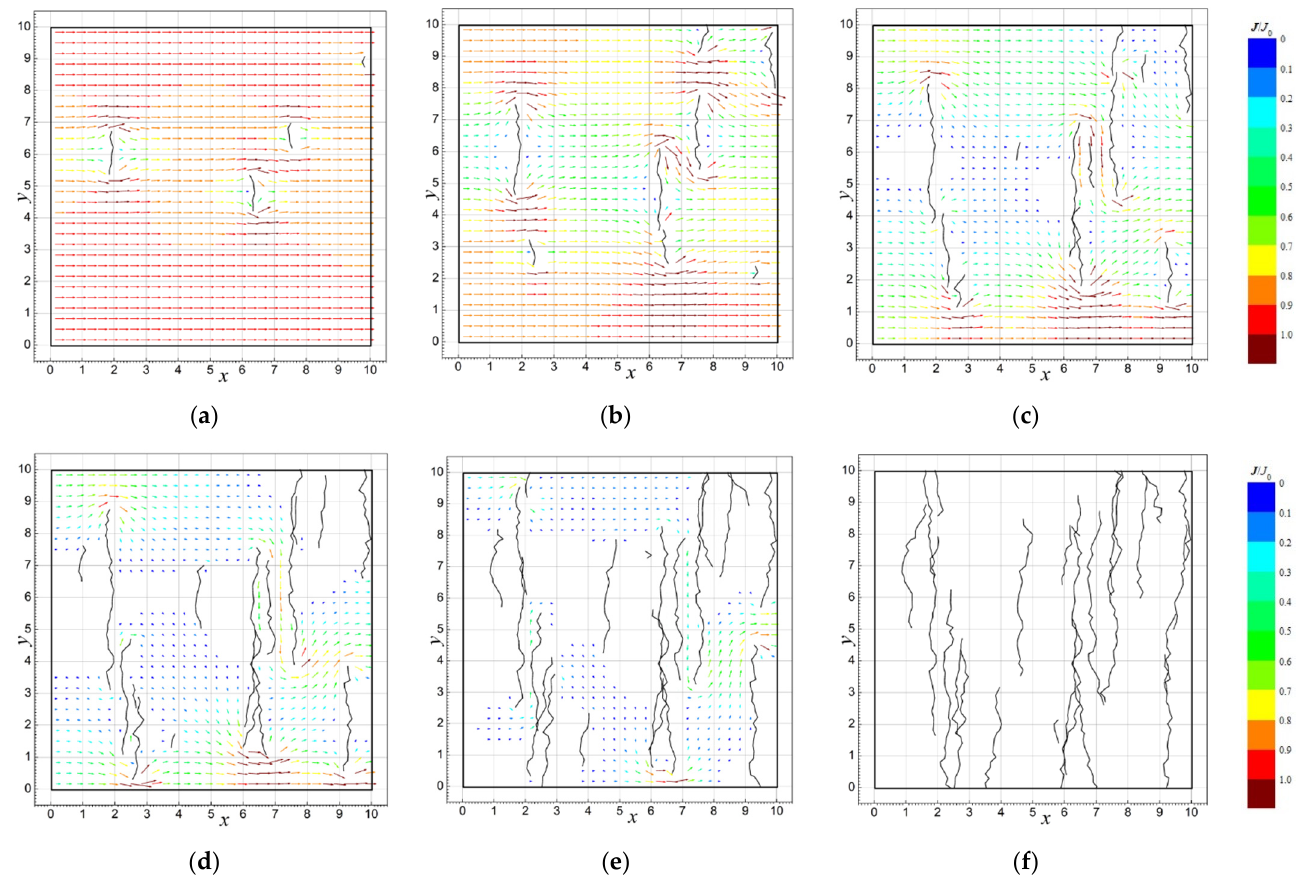
Figure 4. The simulation results of the relative current flow field J/J 0 in the analyzed model of the conductive layer with line defects after ( a ) 4, ( b ) 8, ( c ) 12, ( d ) 16, ( e ) 20, and ( f ) 24 iteration steps; d 0 = 0.2, σ d = 0.04, and σ α = 25 ° .